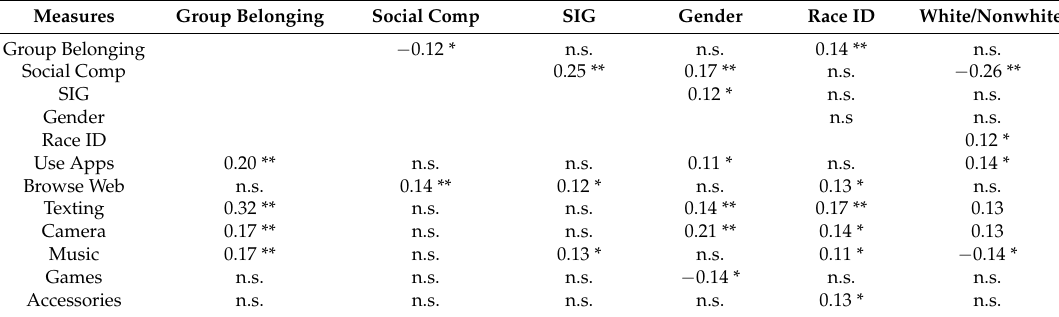
Table 2. Correlations: Social Psychological Attributes, Demographic Characteristics, and Mobile Phone